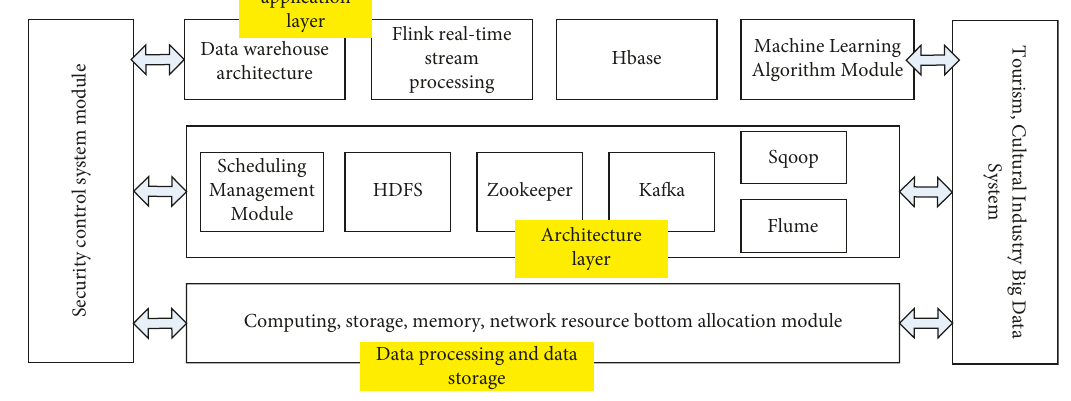
Figure 7: Overall architecture of the big data